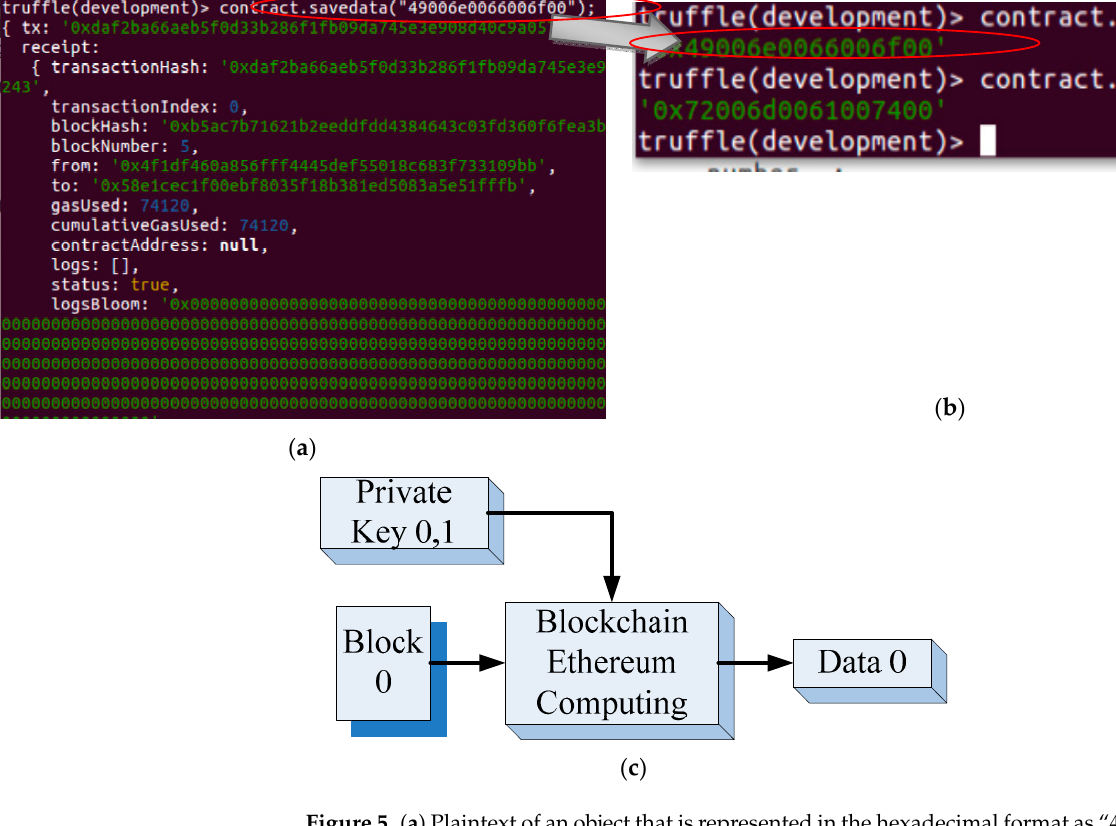
Figure 5. ( a ) Plaintext of an object that is represented in the hexadecimal format as “4900630066006f00” before being chained using the contract.savedata () function; ( b ) data retrieved from the block by using the contract.get () function, which is the same as the original data; and ( c ) obtaining the original plaintext or data by using the corresponding private key.